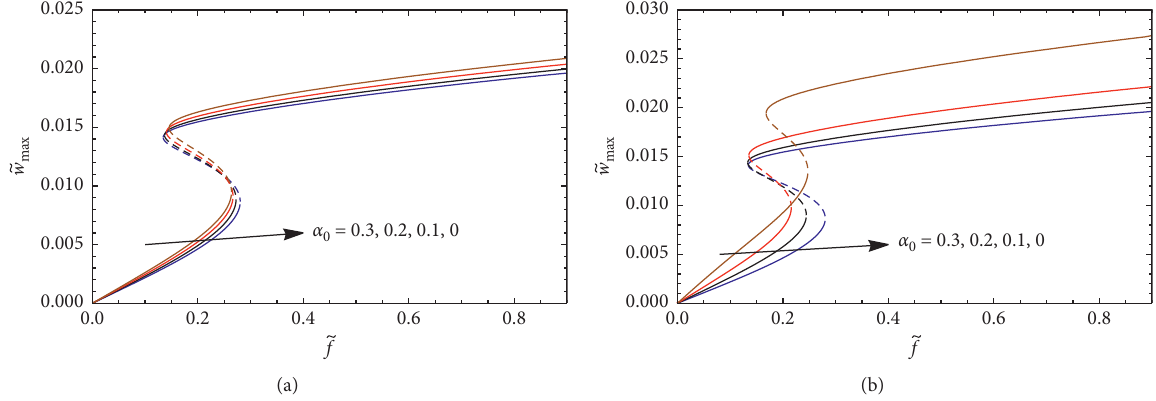
Figure 13: The influence of porosity on the force-response curves of transverse motion of SS BDFG beam when m � c � 0 . 05. (a) Nonuniform porosity (equation (3)). (b) Uniform porosity ( α ( x, y ) � α c d r